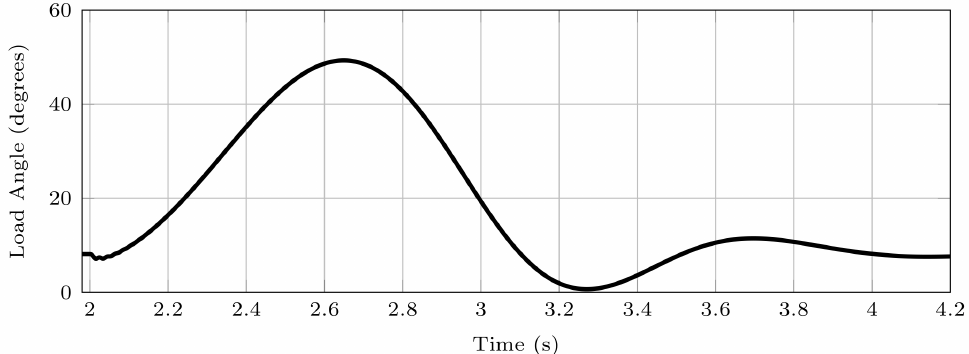
Figure 10. Load angle versus time during the LVRT event of Figure 6.